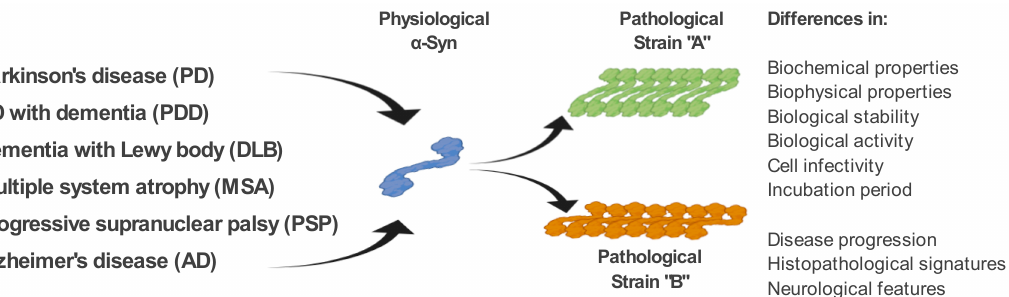
Figure 2. α -Syn strains and their discrimination. Under pathological conditions, di ff erent types of α -Syn aggregates (strains), with specific biochemical, biophysical, and biological properties, occur in the brain of patients with various neurodegenerative diseases. It is the di ff erent properties of these strains that are responsible for the di ff erent clinical manifestations of these diseases. Di ff erential diagnosis of PD and related neurodegenerative disorders is currently quite challenging. We propose several methods to discriminate such disorders, based on the specific physical and biochemical properties of α -Syn strains.